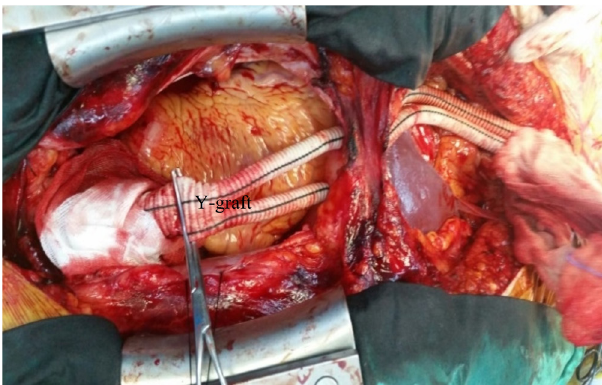
Fig. 3 - Passage of vascular Y-graft from mediastinum to abdominal cavity.